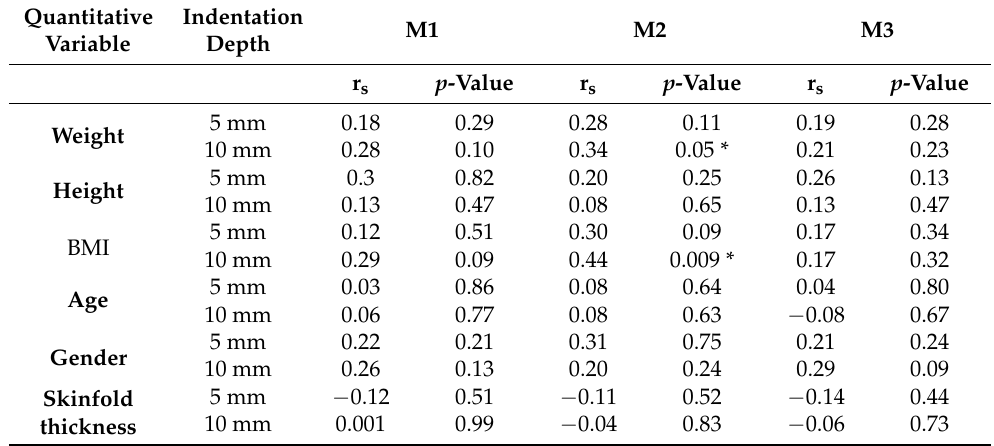
Table 4. Correlations between anthropometric data, skinfold thickness and myofascial tissue